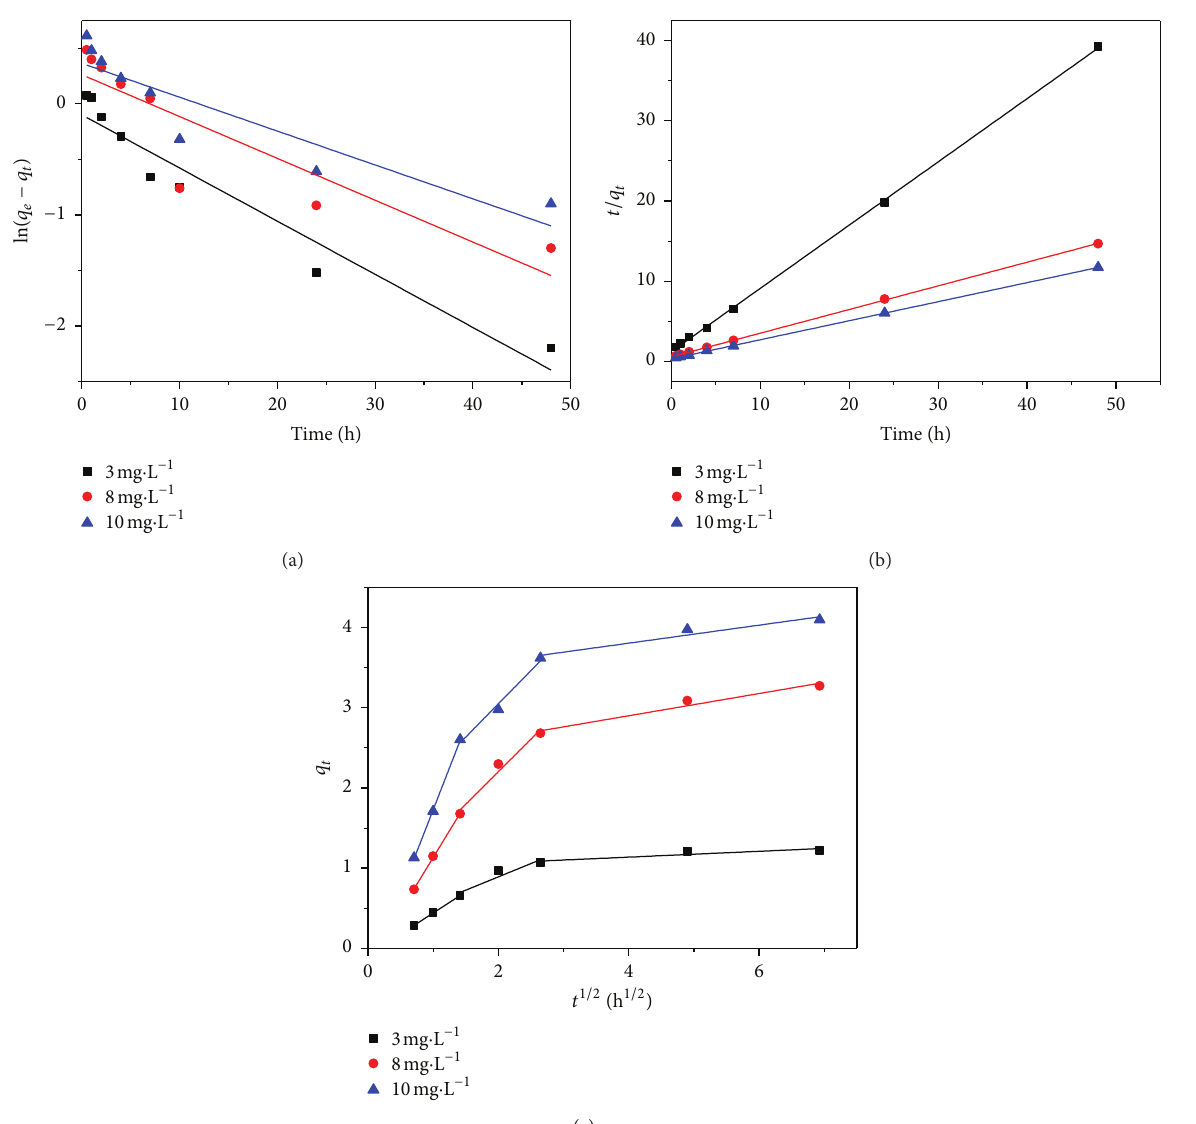
Figure 4: The linearized adsorption kinetics of As (III) on Ce-Al-Fe trimetal oxide adsorbent ((a) pseudo-first-order kinetics model, (b) pseudo-second-order kinetics model, and (c) intraparticle diffusion